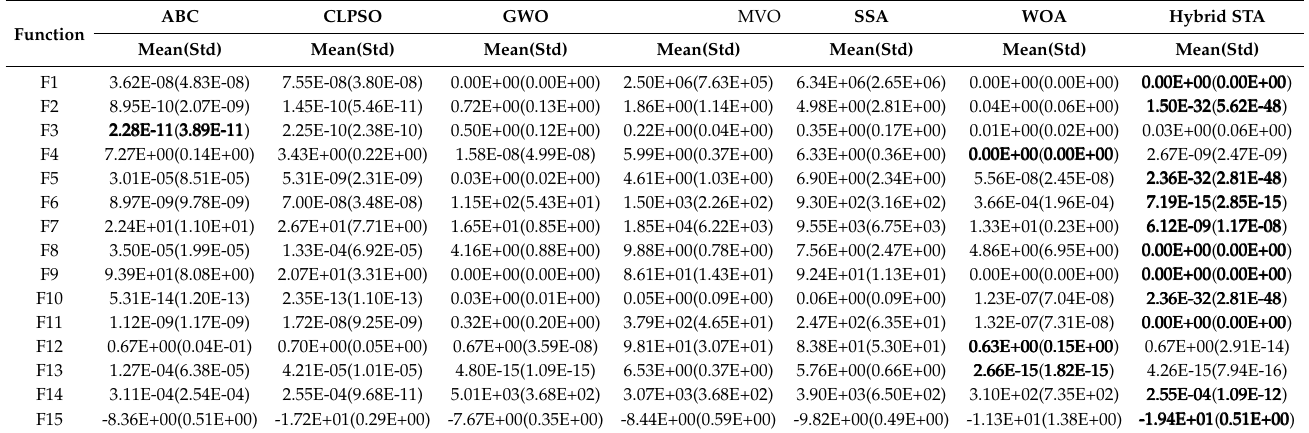
Table 3. Statistical results for different metaheuristic methods with D = 20.